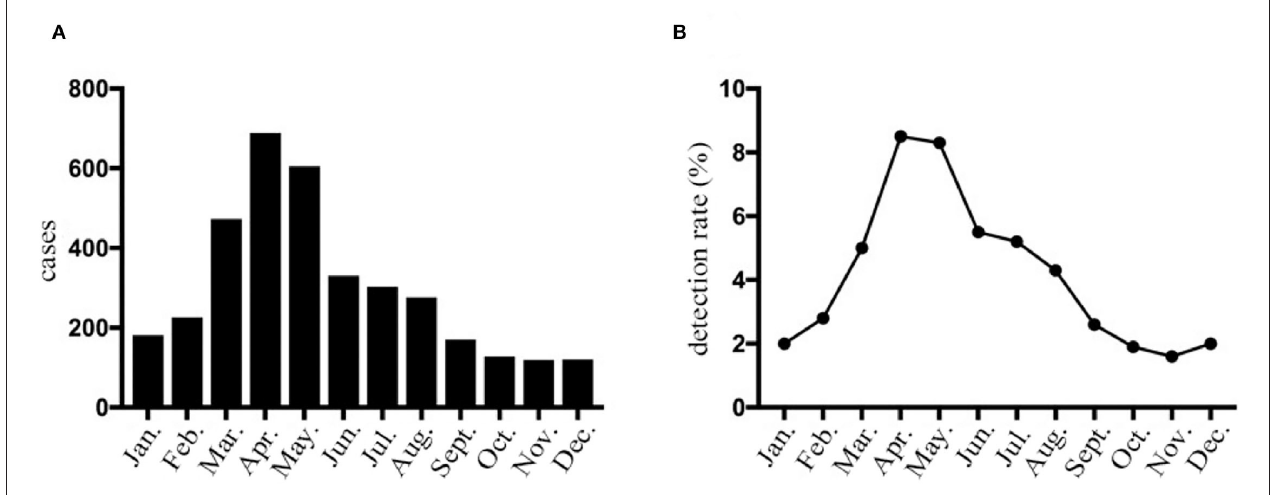
FIGURE 1 | HPIV-3 detection rates of hospitalized children with LRTI in Wenzhou by month. (A) The number of HPIV-3 cases collected in hospitalized children with lower respiratory tract infection according to month. (B) Prevalence of HPIV-3 infections in hospitalized children with lower respiratory tract infection according to